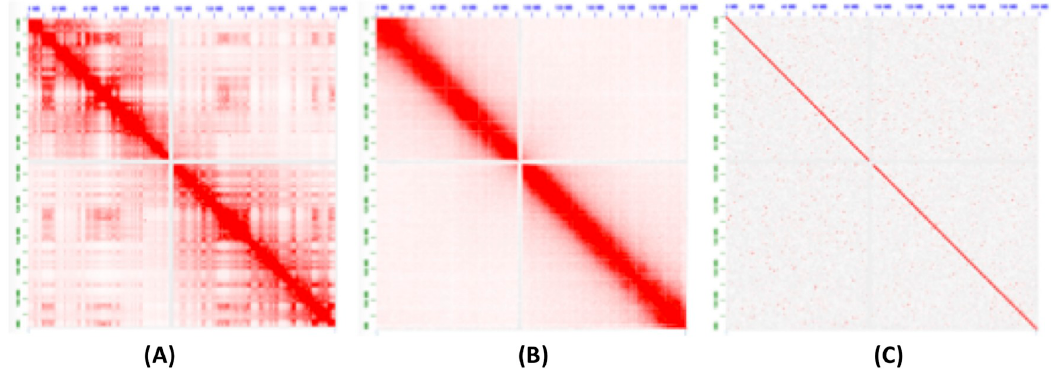
Fig 8. Contact map of Hi-C interactions on chromosome 3 generated by the Juicebox software [41]. The cells sequenced in (A) normal conditions, (B) during mitosis, and (C) Dovetail Chicago.